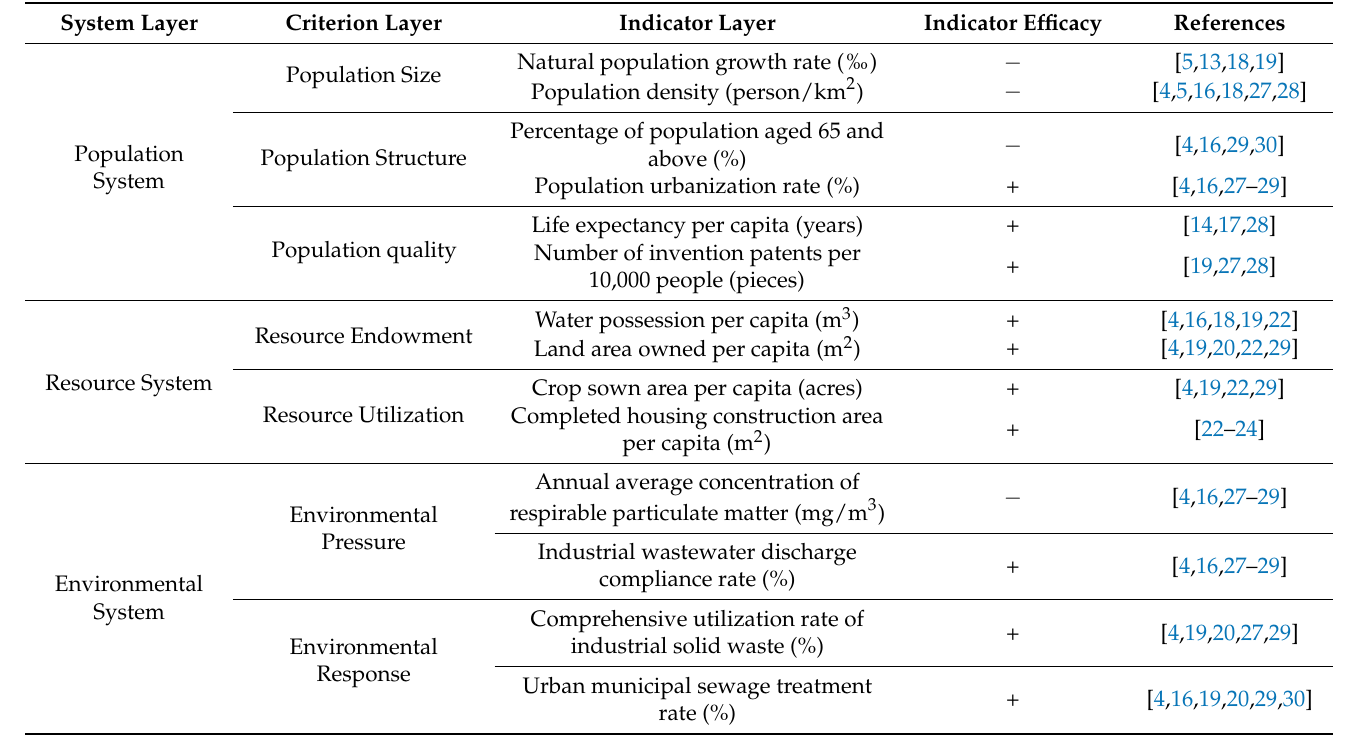
Table 1. Coordinated development evaluation index system for PRE